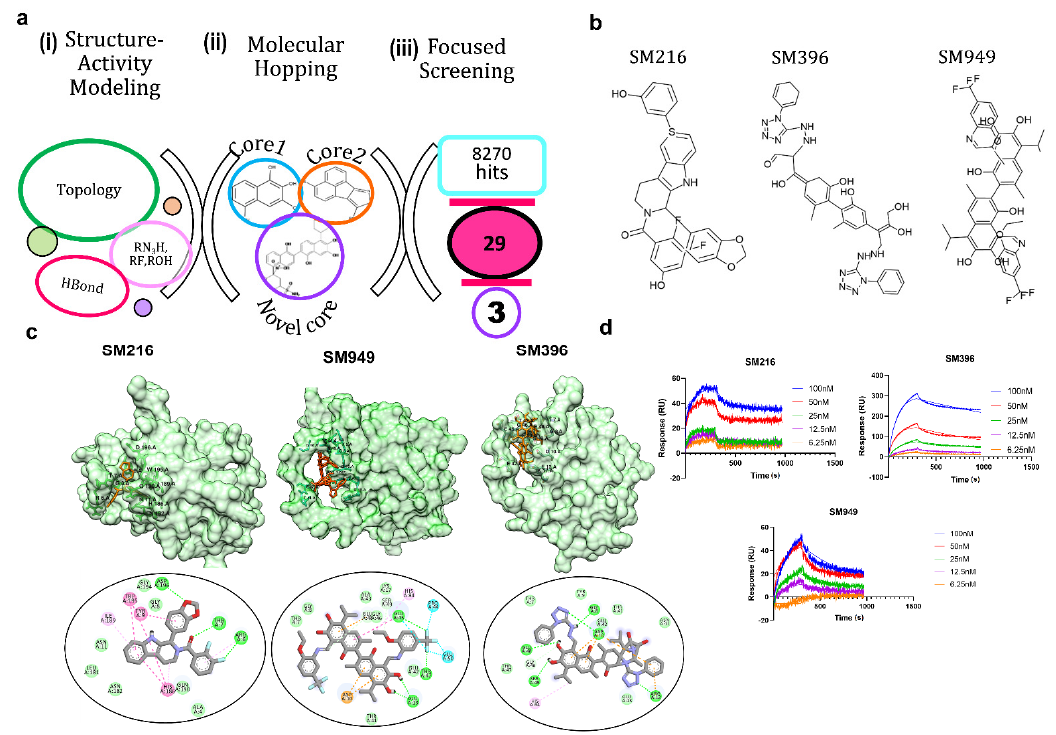
Figure 1. Molecular remodeling and binding of novel scaffolds to BCL − 2 . ( a ) In silico methods for identifying potential BCL − 2 inhibitors: (i) structure–activity modeling to relate the activity of BCL-2 inhibitors with physicochemical descriptors, such as topological parameters, hydrogen bonding descriptors, and functional groups, (ii) molecular hopping for designing novel scaffolds by combining two cores from seven distinct core libraries, and (iii) focused screening of 8270 compounds generated from molecular hopping, which resulted in a set of 29 compounds and narrowed down to three. ( b ) Structures of the top three lead compounds SM216, SM396, and SM949. ( c ) Structures of BCL − 2 bound to SM216, SM396, and SM949 at the BH4 domain, respectively, and interactions are shown below. ( d ) SPR sensorgrams depicting the binding kinetics of the compounds to the BCL − 2 protein are shown. (Drug concentrations used range from 6.25–100 nM). Due to the limited synthetic viability, we searched the existing libraries for